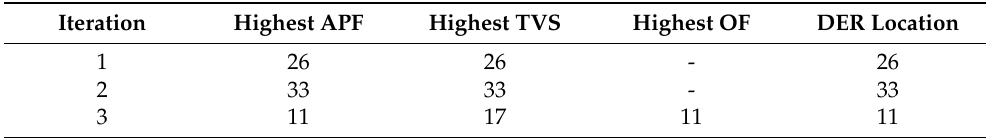
Table 1. Summary of the results of the highest APF, TVS, and OF calculations to determine the DER